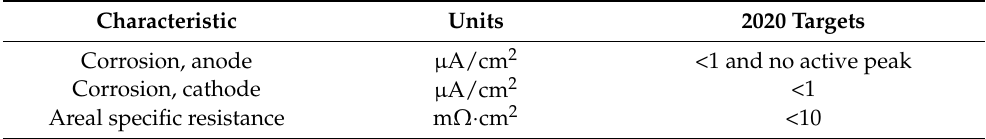
Table 3. DoE technical targets for bipolar plate [20].